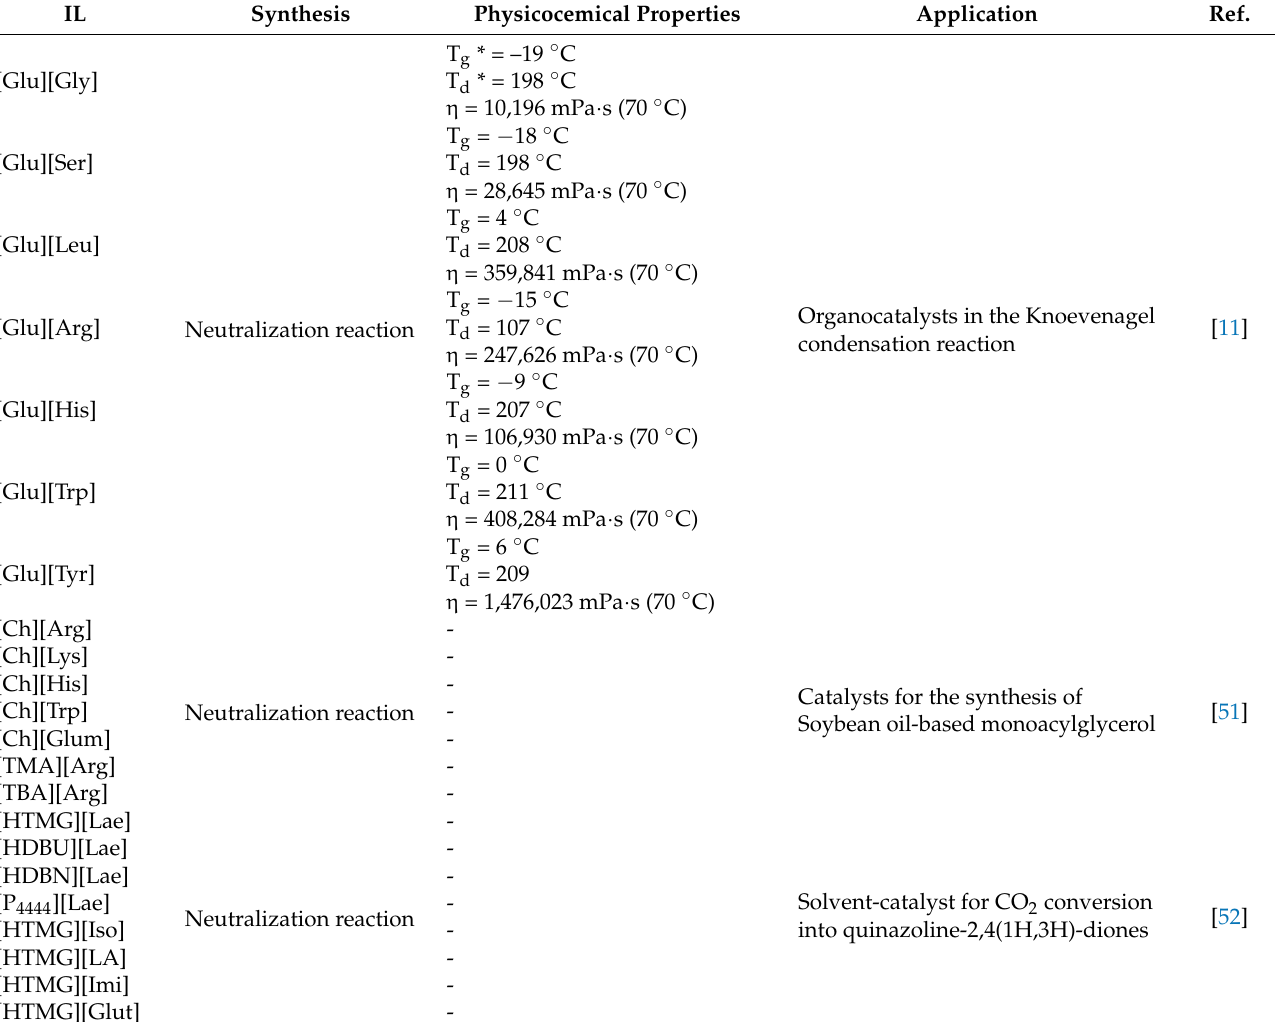
Table 2. Overview of recently investigated Bio-ILs in